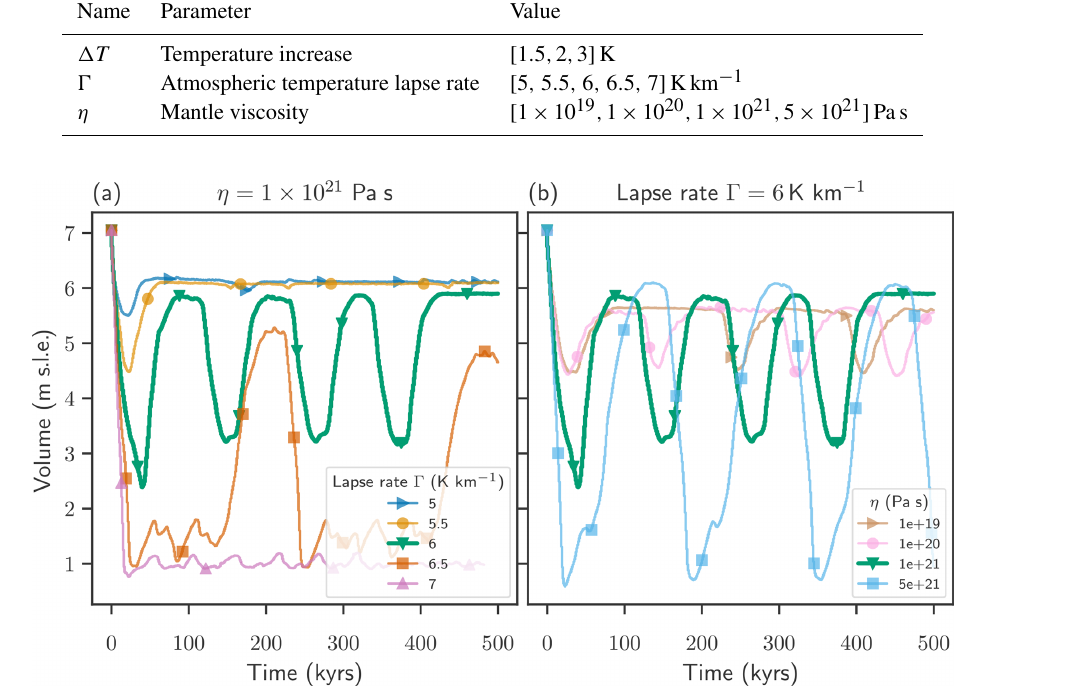
Figure 2. Temporal evolution of Greenland Ice Sheet volume at a temperature anomaly of (cid:49)T = 2K. Depending on the atmospheric temperature lapse rate (between 5 and 7Kkm − 1 ) (a) and on the mantle viscosity (between 1 × 10 19 and 5 × 10 21 Pas) (b) distinct regimes of dynamic responses are observed, including incomplete recovery, quasi-periodic oscillations and permanent loss of ice